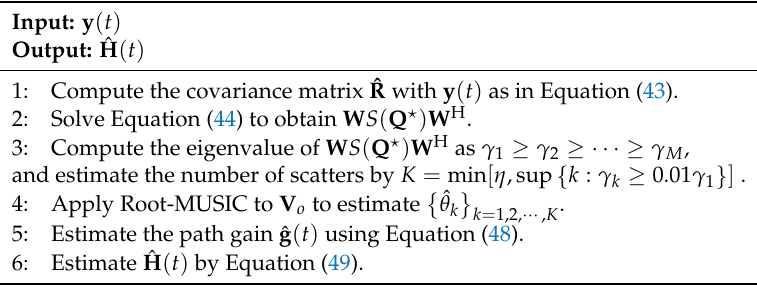
Table 4. Channel estimation algorithm via BS-ANM.